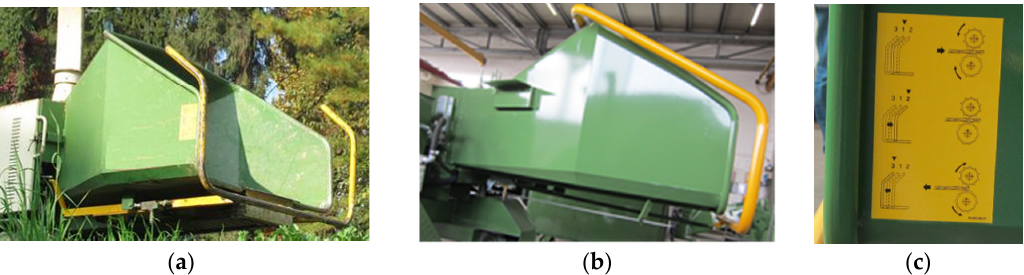
Figure 4. Examples of the different configurations of protective devices. On the left ( a ) the chute was found non ‐ compliant due to the lack of a top protective device while in a more recent unit ( b ) the top protective bar is combined with side and lower protective devices and these respond to the same controls ( c ). This solution does not conform to the standard either as the top protective device should be independent and there are no emergency stops.